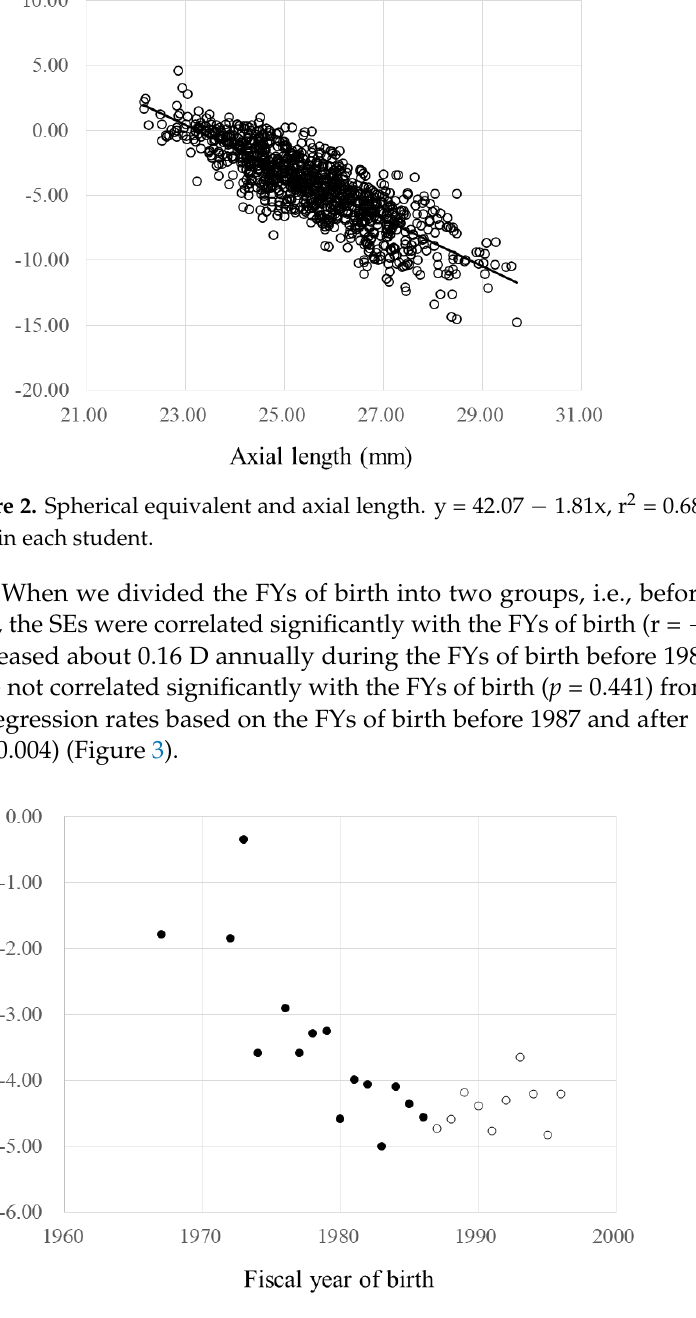
Figure 4. The fiscal year (FY) of birth and mean axial length. ● , data during the FYs of birth before 1987. ○ , data during the FYs of birth of 1987 and after. During the FYs of birth before 1987, y = − 78.9 + 0.0527x, r = 0.157, p = 0.034. During the FYs of birth of 1987 and after, p = 0.599. The regression of spherical equivalent by FYs of birth before 1987 and after, p = 0.004 (ANCOVA). The myopia prevalence rates were not correlated significantly with the FYs of birth before and after 1987 ( p = 0.428, p = 0.080, respectively). In contrast, the prevalence rates of high myopia were correlated significantly with the FYs of birth (r = 0.851, p < 0.001) and